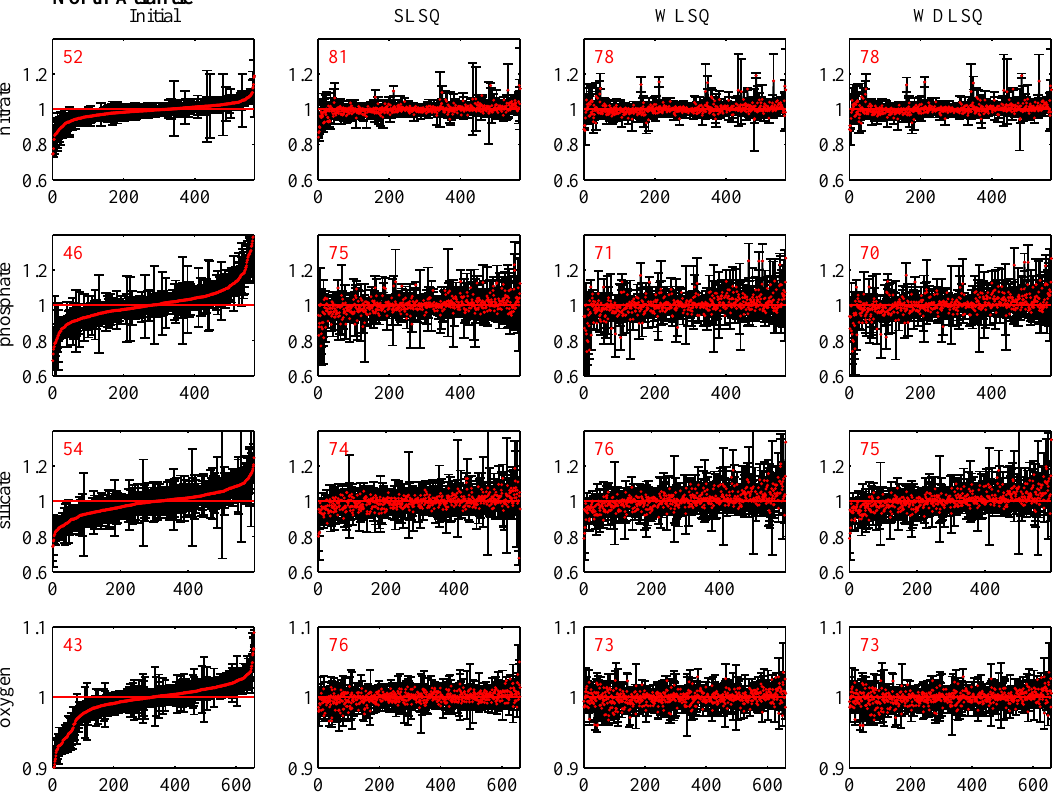
Figure 4. The results of an inversion of the North Atlantic nutrient and oxygen data: Left column (initial) shows the o ff sets of all the crossovers sorted by o ff set (red dots) and the weighted standard deviation of the crossover (black bars); the following columns shows the o ff sets after the corrections suggested by the SLSQ, WLSQ and WDLSQ inversions has been applied to the data. The numbers in the panels indicate the percentage of crossovers that are indistinguishable from zero within their